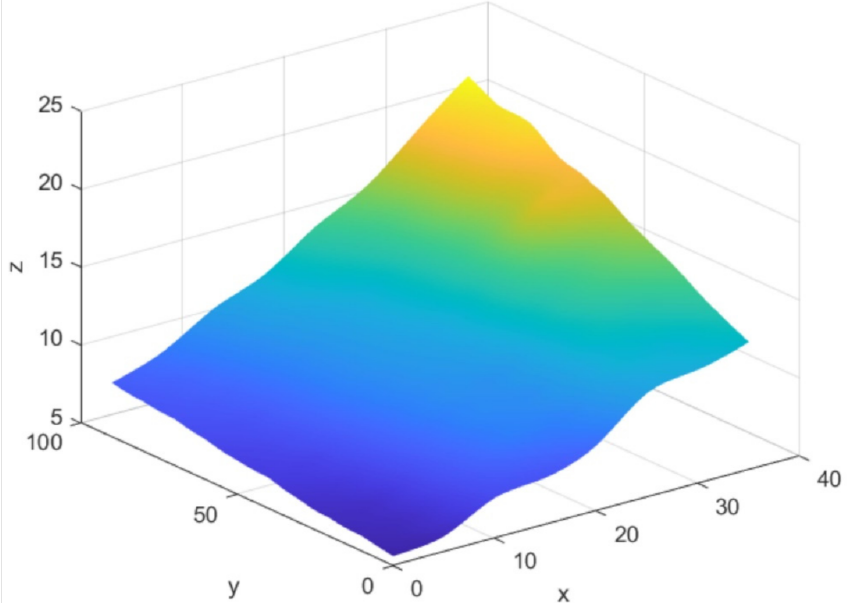
Figure 8. Cloud diagram of grasping capacity of anchoring mechanism. X. Y, Z, respectively, represent the angle of the driving motor of the anchoring mechanism ( ◦ ), the included angle between the direction vector of the external force and the direction vector of the ground ( ◦ ), and the maximum force that the anchoring mechanism can bear